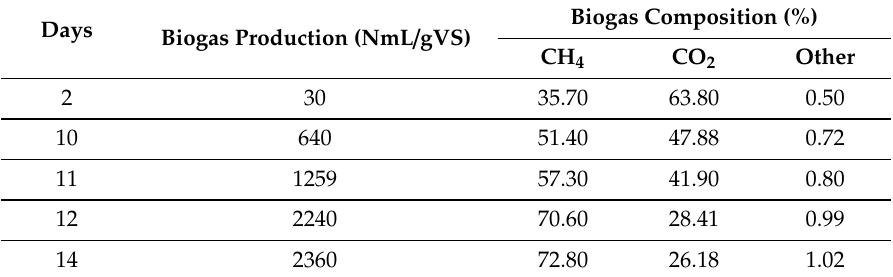
Table 6. Composition of biogas produced.